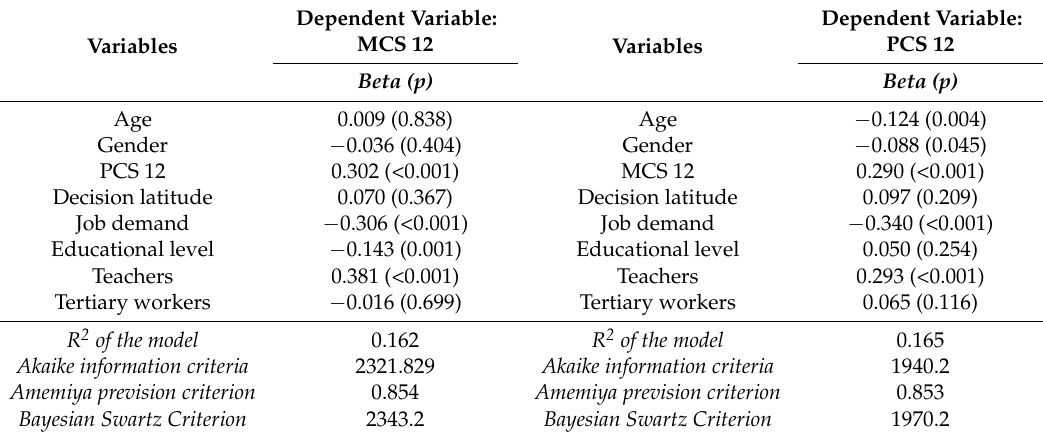
Table 2. Predictors of MCS 12 and PCS 12 in the whole study